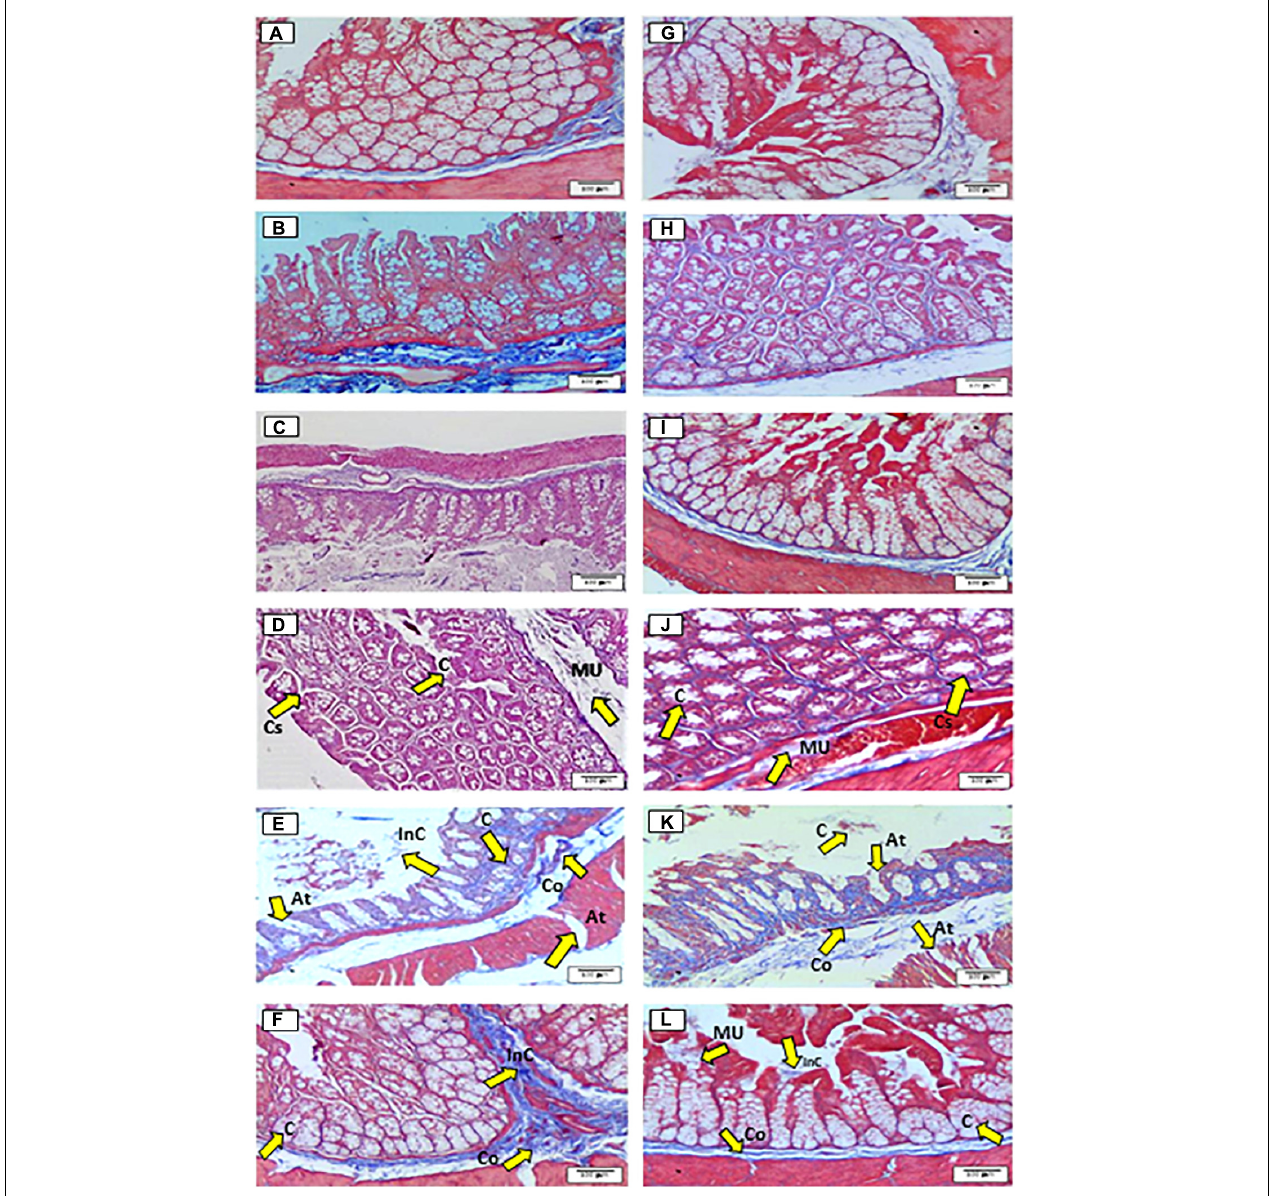
FIGURE 1 | Histological effects of the diets on the general structure of the epithelium of the cecum (A–F) and proximal colon (G–L) in rats fed for 35 days with different doses of Agave salmiana fructans. In addition, panels (A,G) are the control of the cecum and proximal colon, respectively, and panels (B,H) are the doses of 5%, with panels (C,I) of 10%, panels (D,J) of 12.5%, panels (E,K) of 15%, and panels (F,L) of 20%. At, atrophy; C-cells, co-collagen; Cs, cellular spaces; InC, inflammatory cell infiltrates; MU,